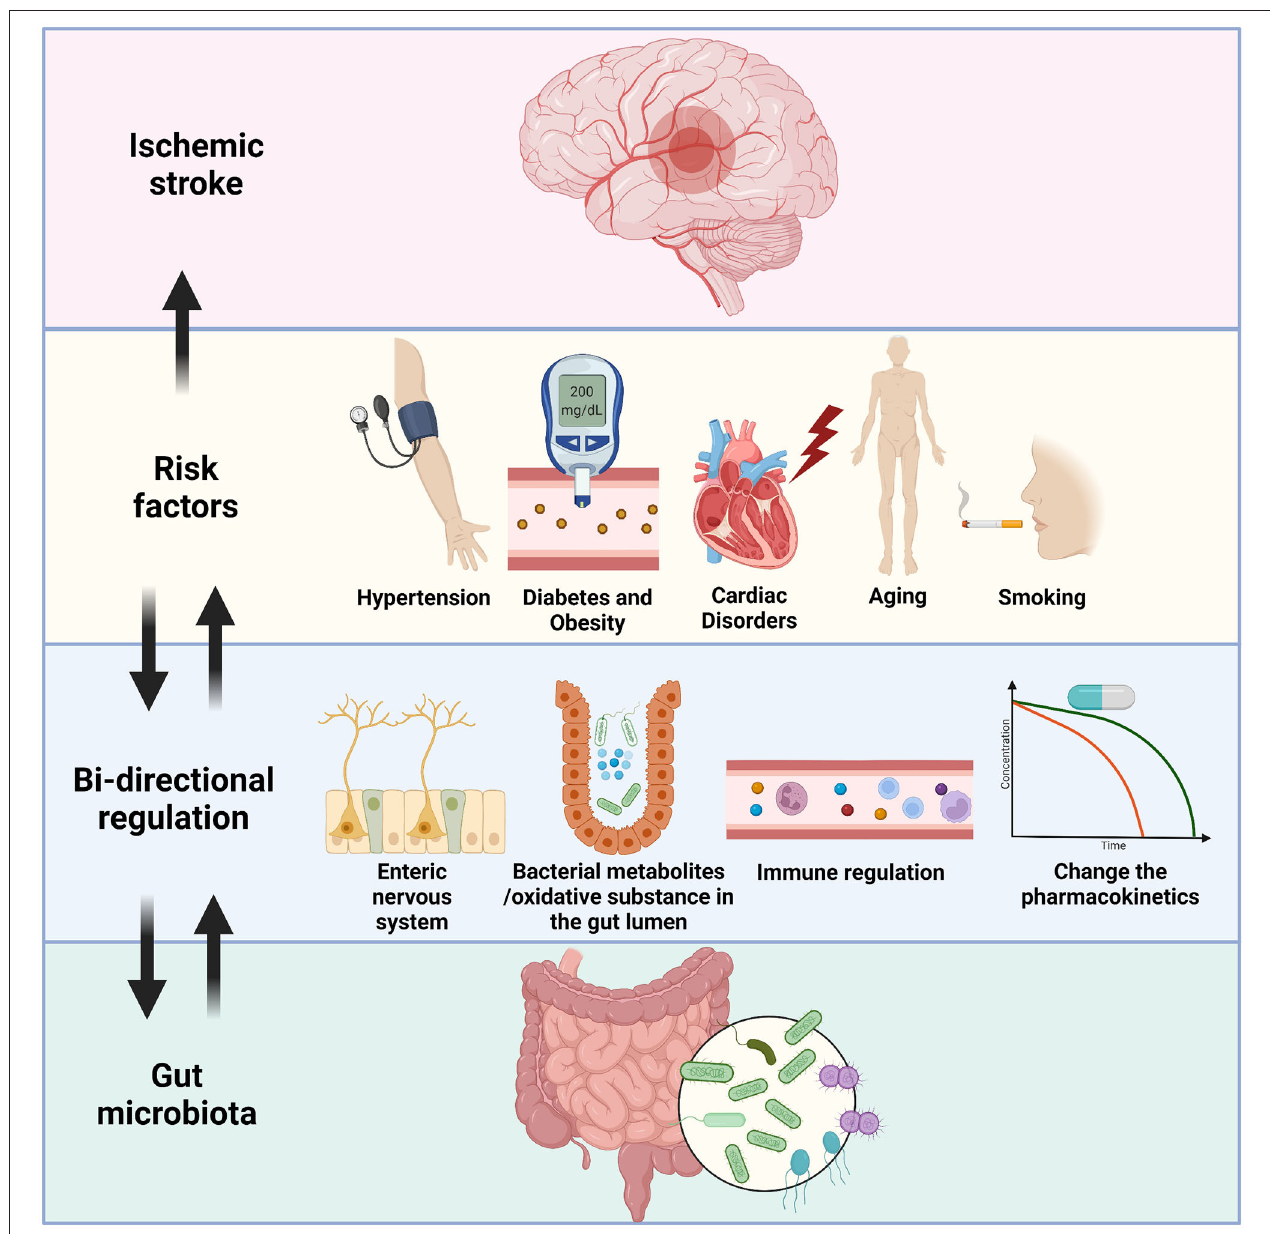
FIGURE 1 | An illustration of the bi-directional relationship between gut microbiota and the risk factors of IS. Hypertension, diabetes/obesity, cardiac disorders, aging, and smoking are well-known risk factors of IS, and IS patients with these factors usually have unsatisfied prognosis. Gut flora could send signals through the enteric nervous system and reach specific brain areas like hypothalamus to control blood pressure and eating habit of the host. Some probiotics showed ability to lowering down the severity of these pre-stroke disorders by reduction of oxidative substances or secretion of short-chain fatty acids. Overreacted immune cells, including T cells, monocytes, and microglia were restricted by the administration of probiotics. Furthermore, the bacteria could also affect the pharmacokinetics of drugs, thus indirectly inhibit the development of diseases like hypertension. On the other hand, the gut dysbiosis is detected in the people who had these risk factors, which could fasten the general pathologic processes, and facilitate the onset of IS by similar mechanisms mentioned above.